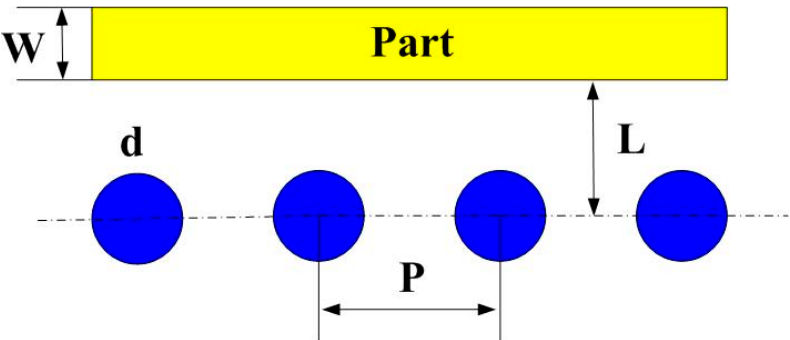
Figure 2. Schematic illustrations of the four cooling channel design parameters.